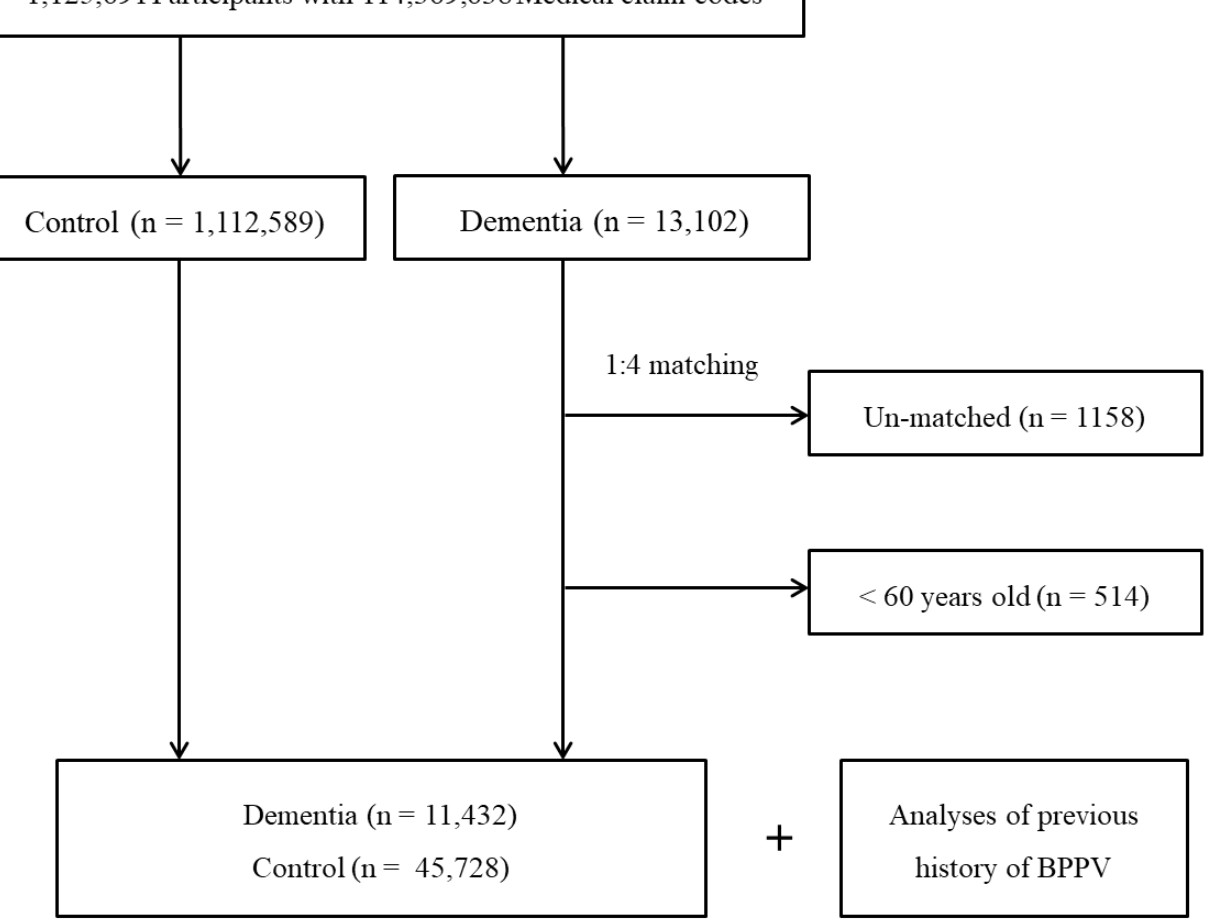
Figure 1. Schematic illustration of the participant-selection process used in the study. From a total of 1,125,691 participants, 11,432 patients with dementia were matched with 45,728 controls for age, sex, income, region of residence, and medical histories.